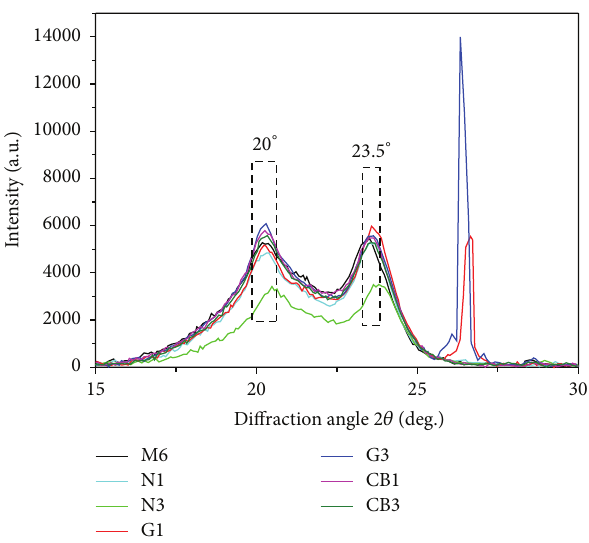
Figure 2: Wide-angle XRD diagram of nanocomposites.